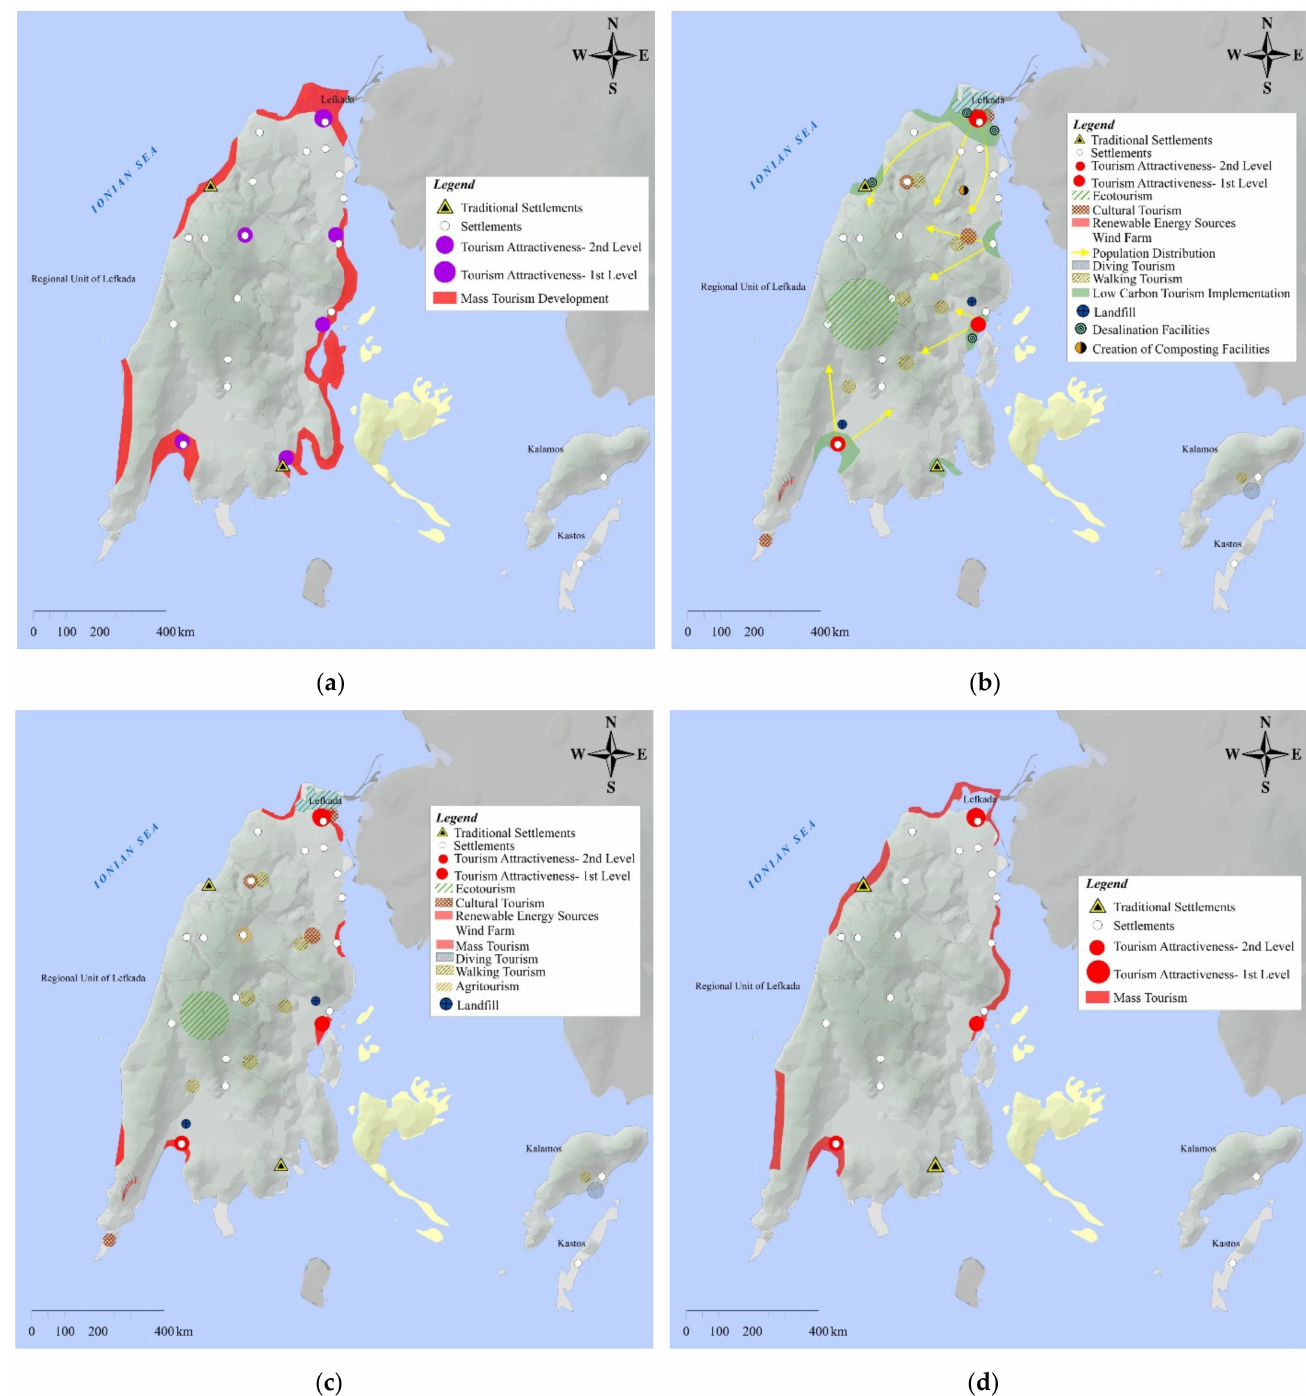
Figure 4. Maps depicting the four different tourism planning scenarios: ( a ) High-Carbon Tourism (HCT), ( b ) Low-Carbon Tourism (LCT), ( c ) Existing Tourism (ET), and ( d ) Middle-Carbon Tourism